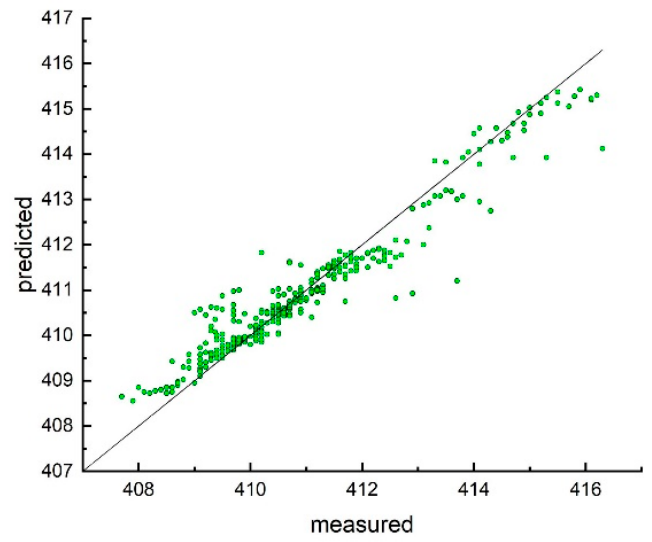
Figure 5. Distribution of the experimental and predicted values of the absorption maximum position calculated by consensus model developed with n = 335 compounds experimentally measured in this work.